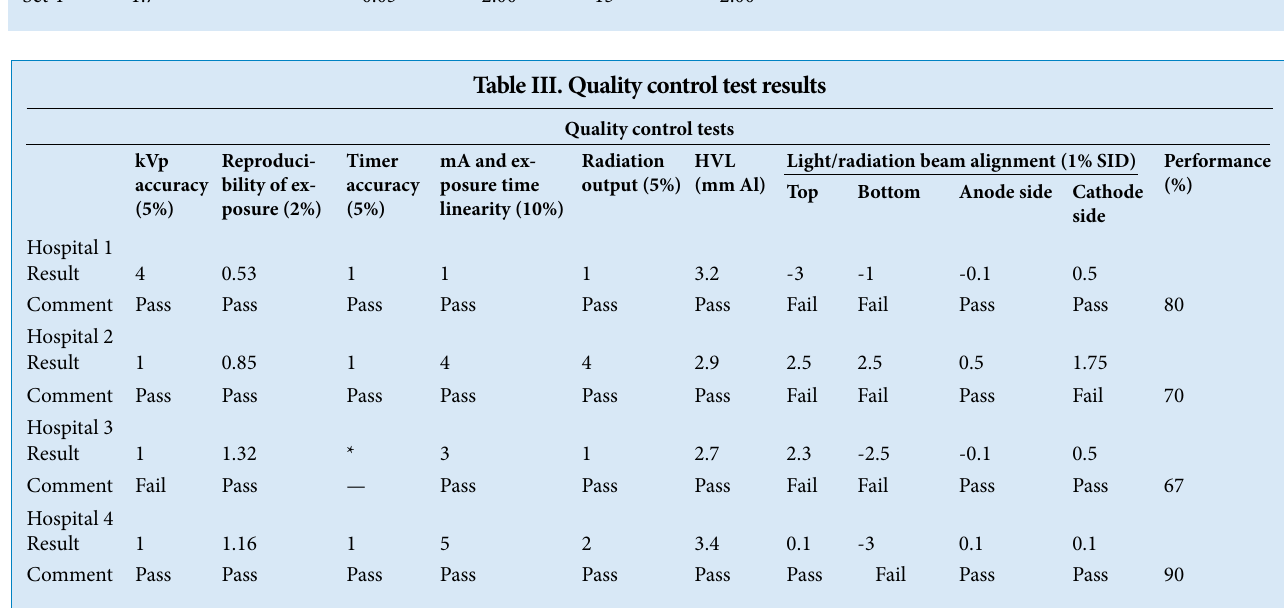
Table III. Quality control test results